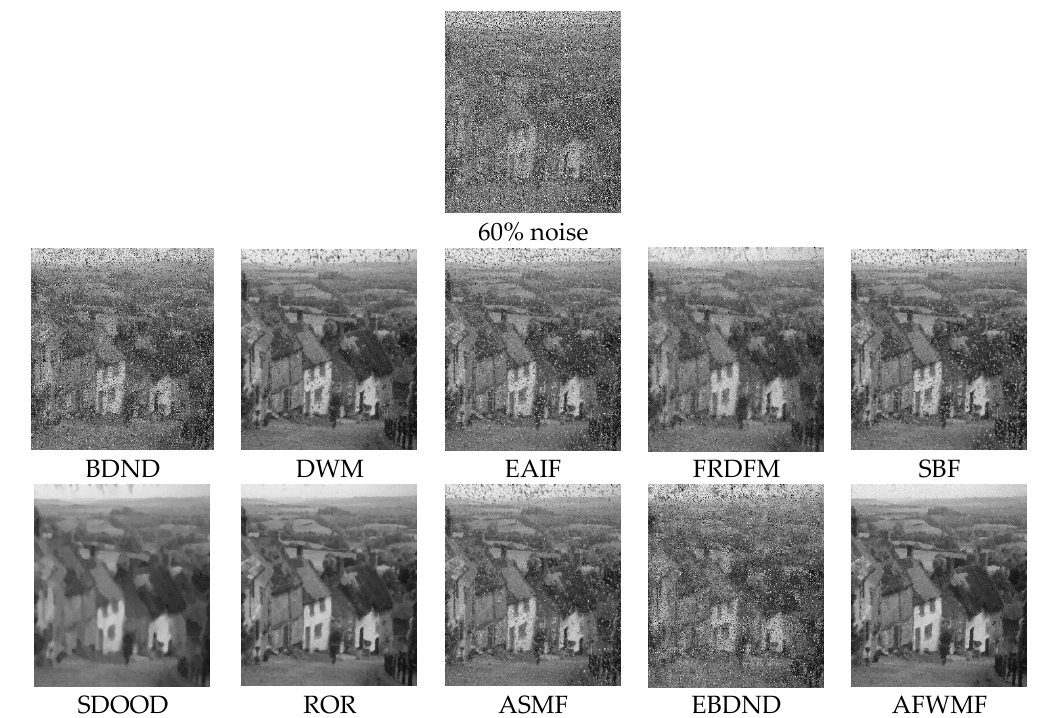
Figure 16. Repair map with a 60% random value of impulse noise for the Gold Hill image.